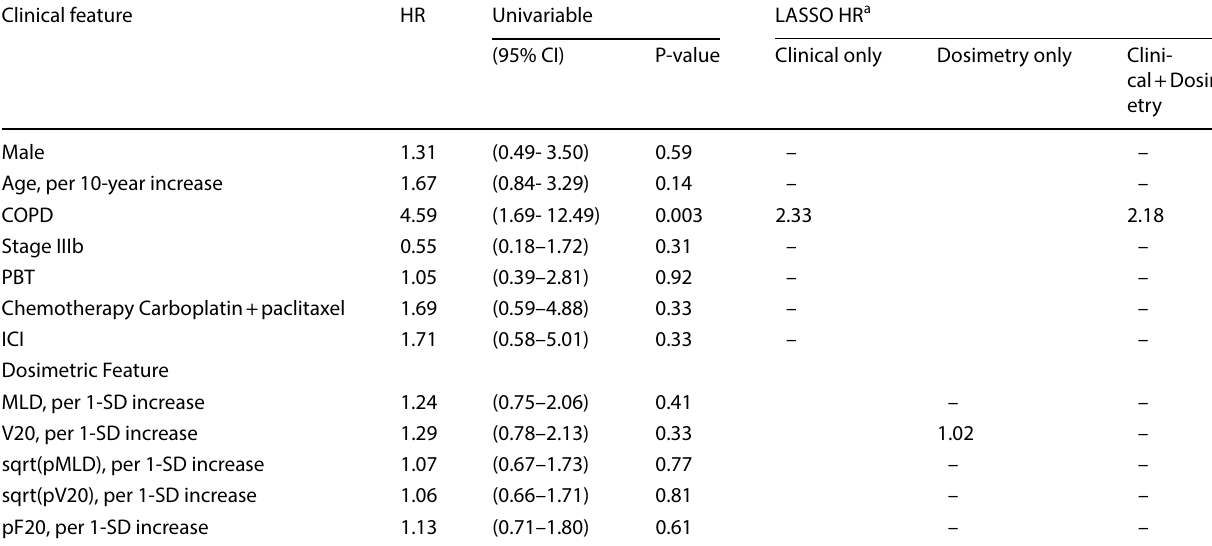
Table 2 Univariable and multivariable associations of clinical factors and lung dosimetric parameters with pneumonitis risk in the setting of functional lung avoidance radiation treatment